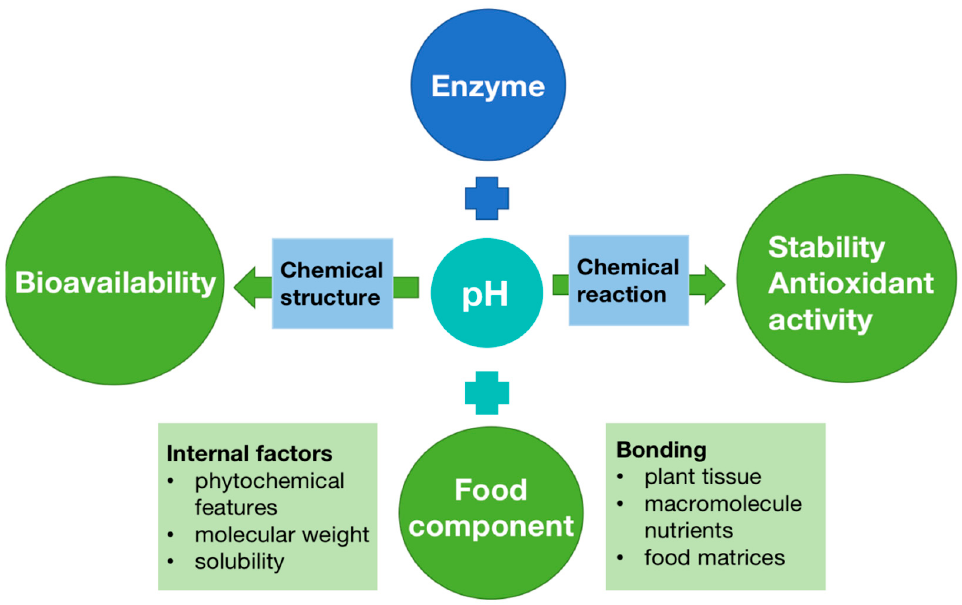
Figure 4. Parameters affecting the bioavailability of bioactive compounds [89] .